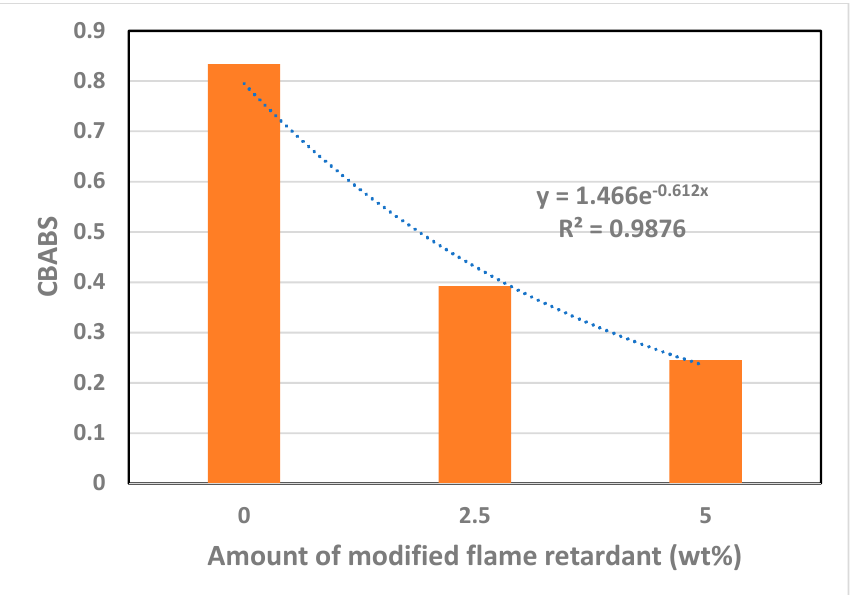
Figure 11. Relationship with CBABS by increasing the amount of modified flame retardant added.